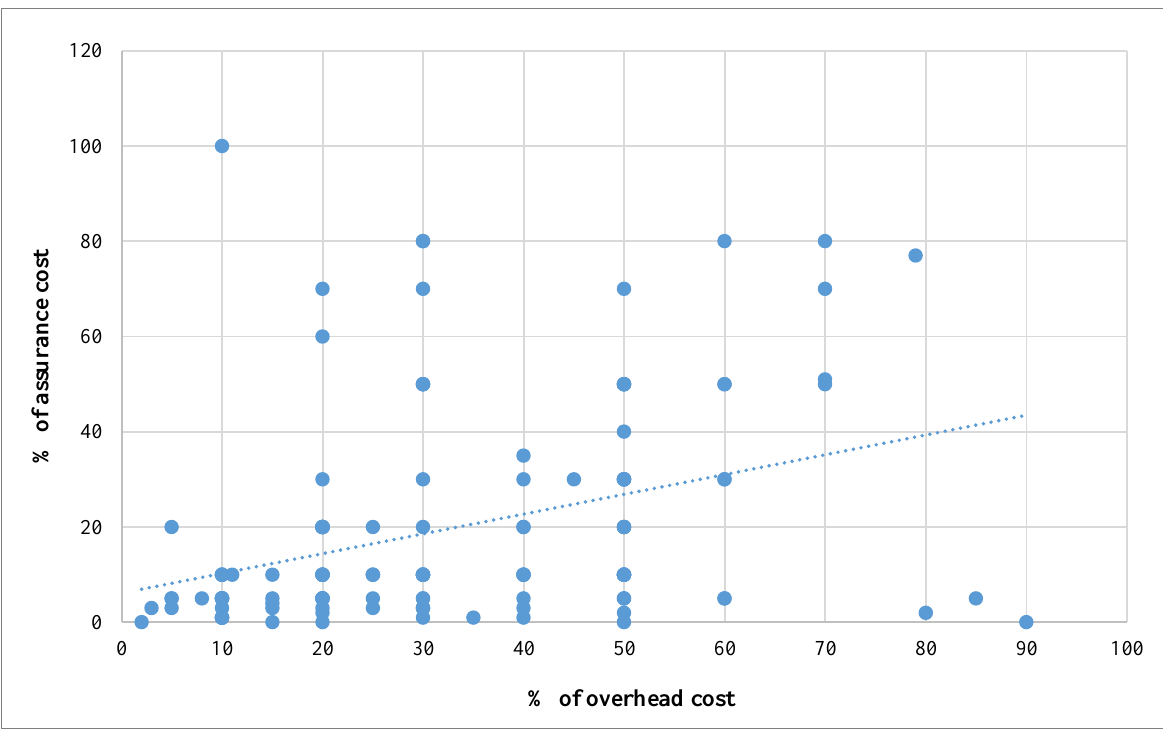
Figure 3. Scatter diagram with regression